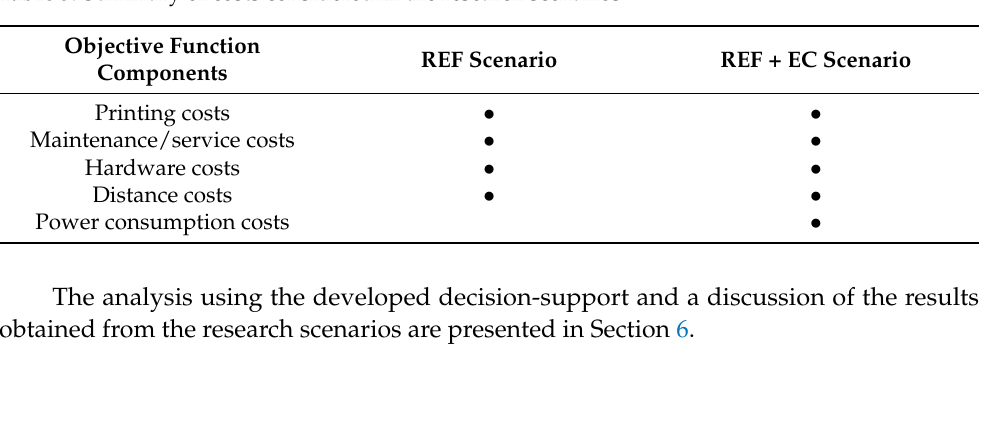
Table 5. Summary of costs considered in the research